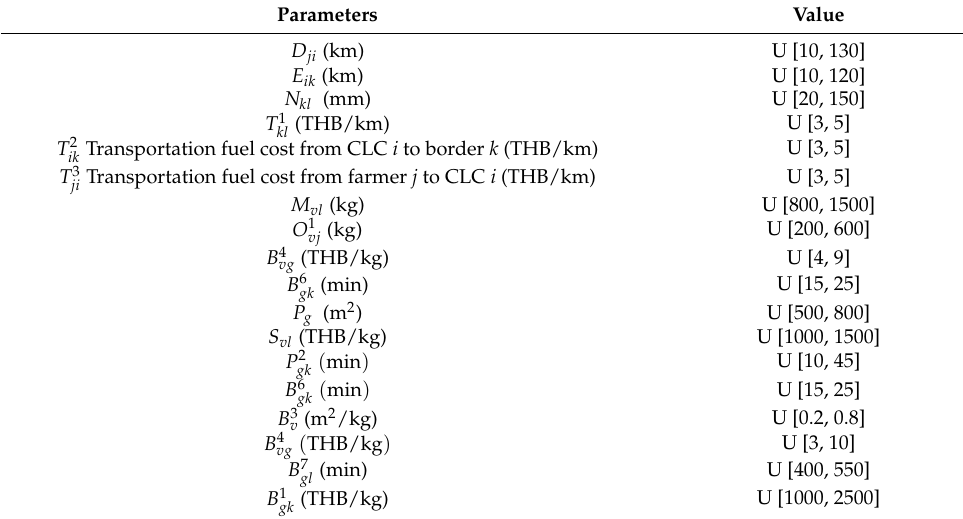
Table 11. Range of data randomly generated for each problem